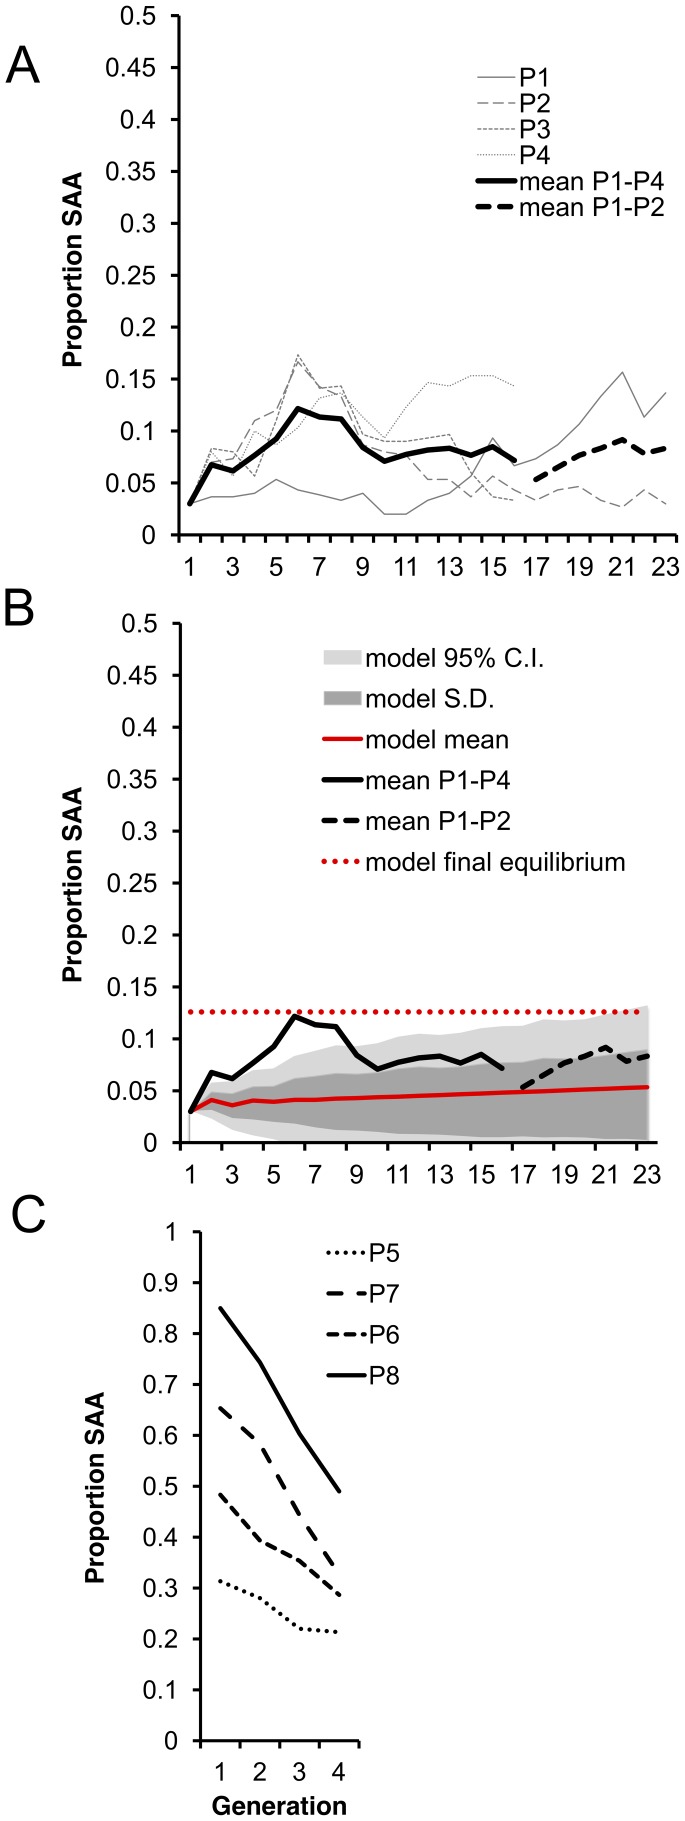
Experimental evolution of the SAA.(a) Mean SAA frequency changed significantly over the 16 experimental generations in a log-linear manner (ln linear term, χ2
1 = 94.1, p<0.0001, linear term, χ2
1 = 0.30, p = 0.58). SAA frequency increased significantly from the 1st to 2nd generation (χ2
1 = 6.07, p = 0.014), indicating that the SAA bearing males had high fitness relative to controls (SAA was present only in males in the 1st generation) and confirming that SAA frequency increases when rare. Segmented regressions showed that mean SAA frequency continued to increase until generation 6 (change from generation 1–6, χ2
1 = 6.71, p = 0.0096) reaching ∼12%. SAA frequency then underwent a significant decline to ∼8% at generation 10 (change from generation 6–10, χ2
1 = 5.14, p = 0.023) and thereafter did not change significantly in frequency (change from generation 10–16, χ2
1 = 0.013, p = 0.91). Populations P1 and P2 only were maintained for generations 17–23. (b) The model (red solid line) predicted a steady increase in SAA frequency until an equilibrium frequency of 12.6% after 700 generations (red dashed line). The range of values expected from the model is shown by the 95% confidence limits (light grey area). (c) SAA frequency declined over 4 generations for each of the P5–8 populations (χ2
1 = 10.89, p = 0.001). There was a significant interaction between the initial SAA frequency and generation, showing that the higher the initial SAA frequency, the further it declined (χ2
1 = 11.049, p = 0.0009).